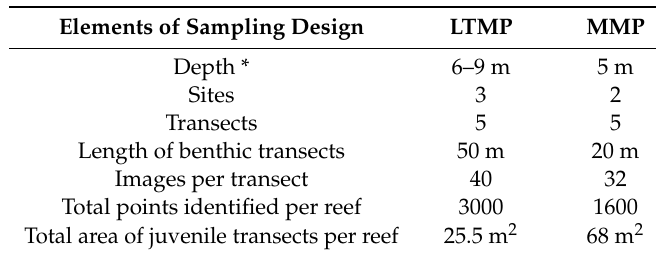
Table 1. Sampling design of two monitoring programs used to estimate benthic cover and juvenile density at each